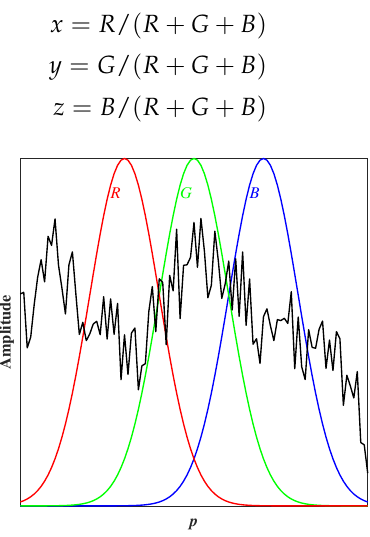
Figure 7. Schematic diagram of tri-stimulus chromatic processors ( R , G , B ) superimposed upon a complex signal S ( p ) as a function of a parameter p